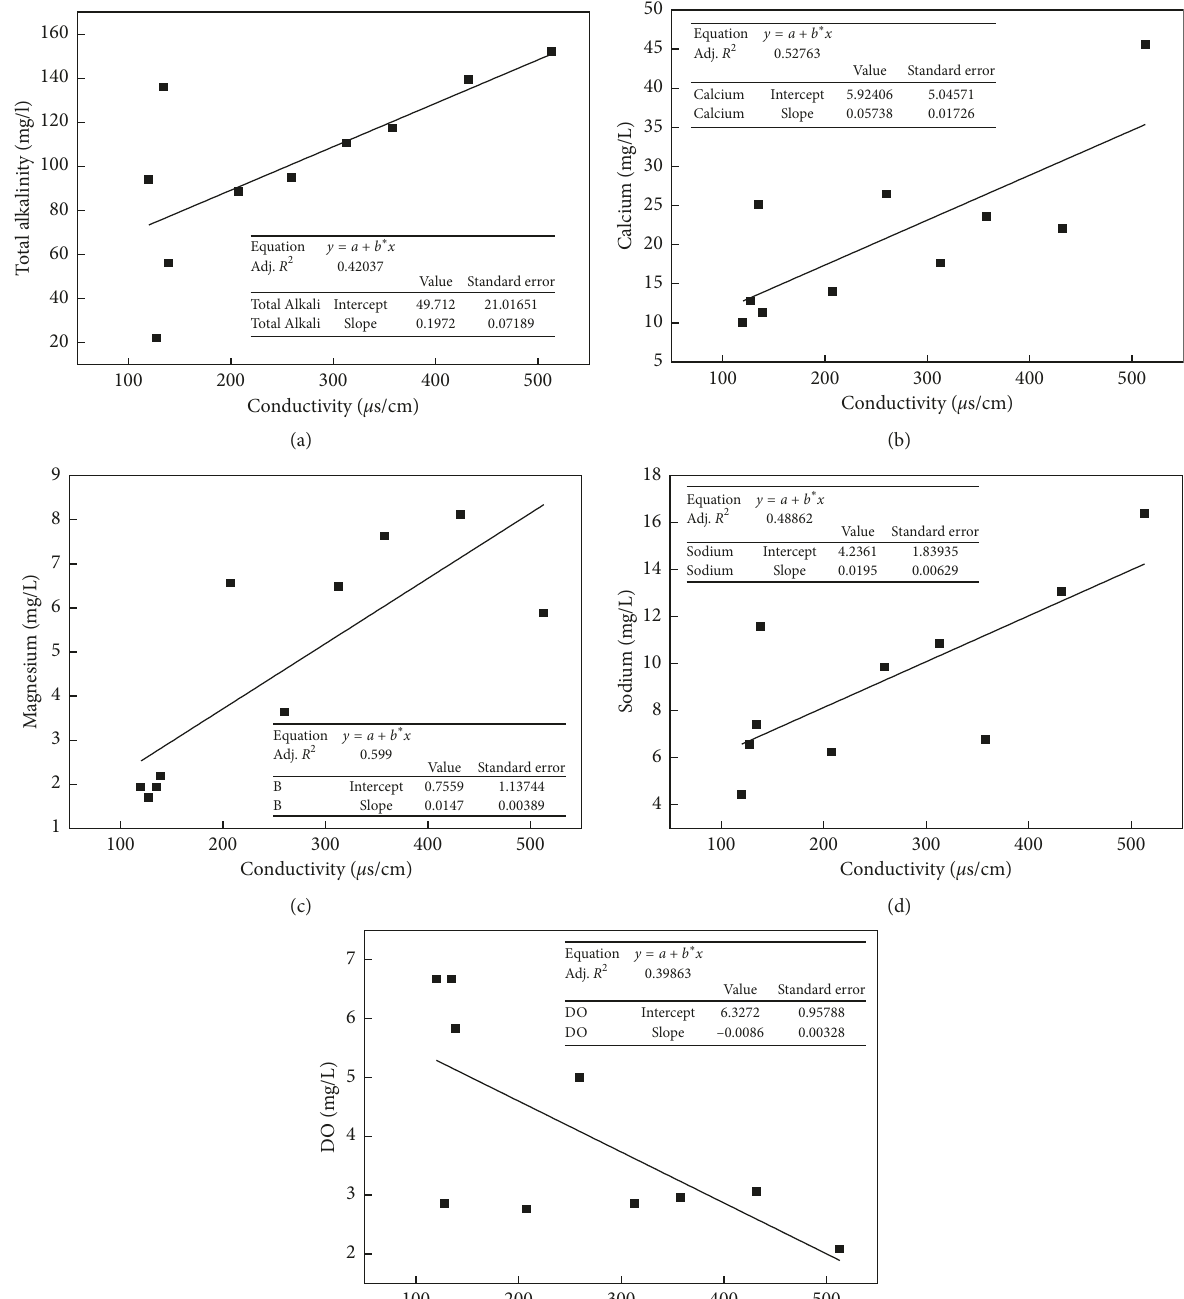
Figure 3: Correlation of total alkalinity, calcium, magnesium, sodium, and DO with electrical